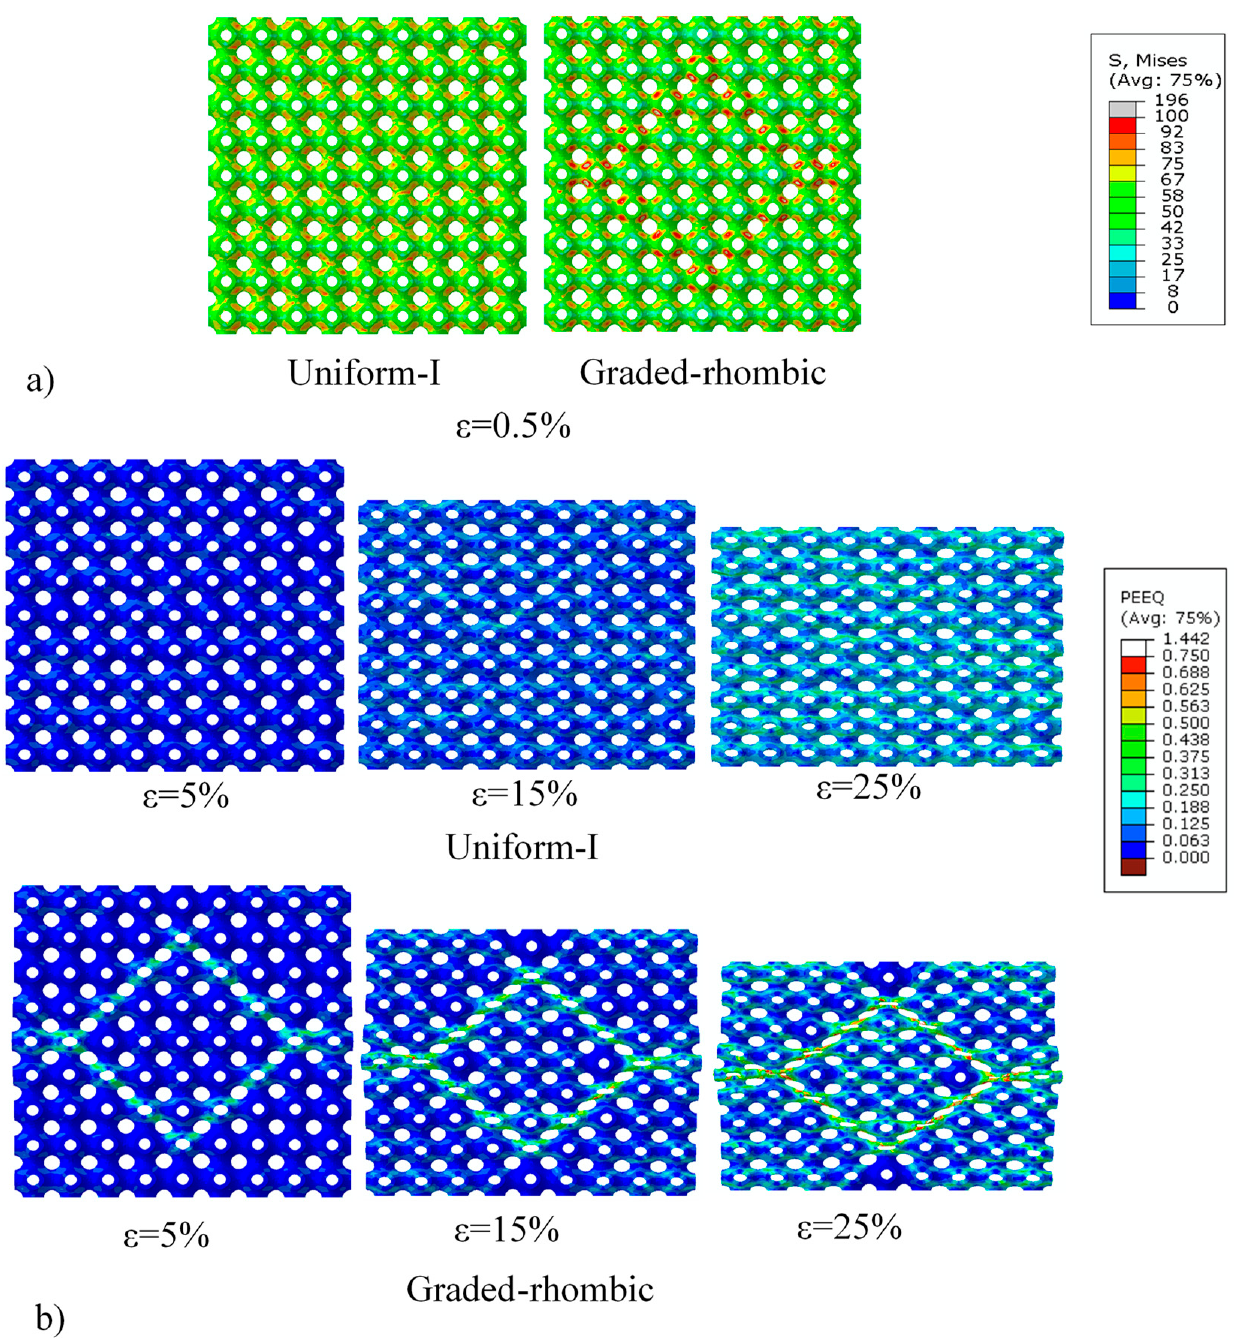
Figure 7. ( a ) Von Mises stress distribution and ( b ) equivalent plastic strain for the Uniform–I and graded ‐ rhombic struc ‐ ture.